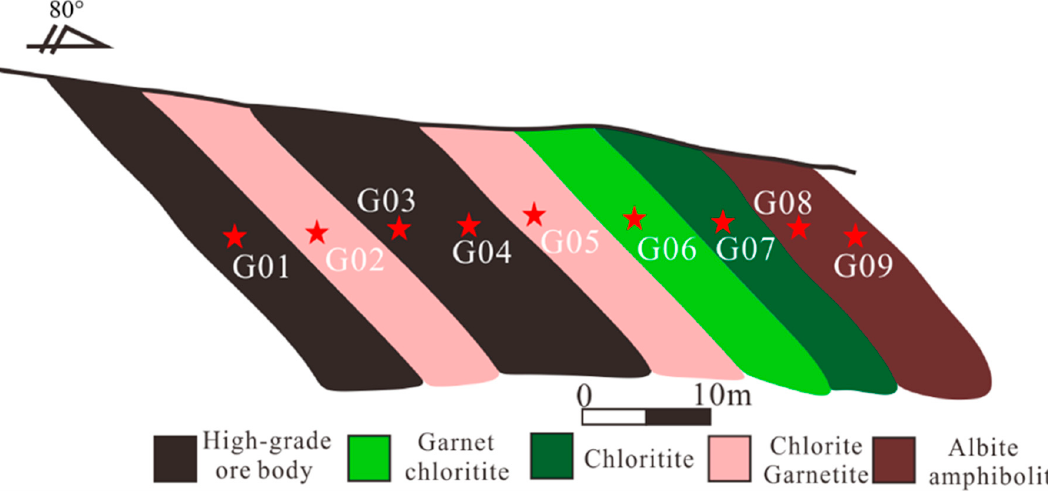
Figure 3. Schematic diagram of profile sampling.